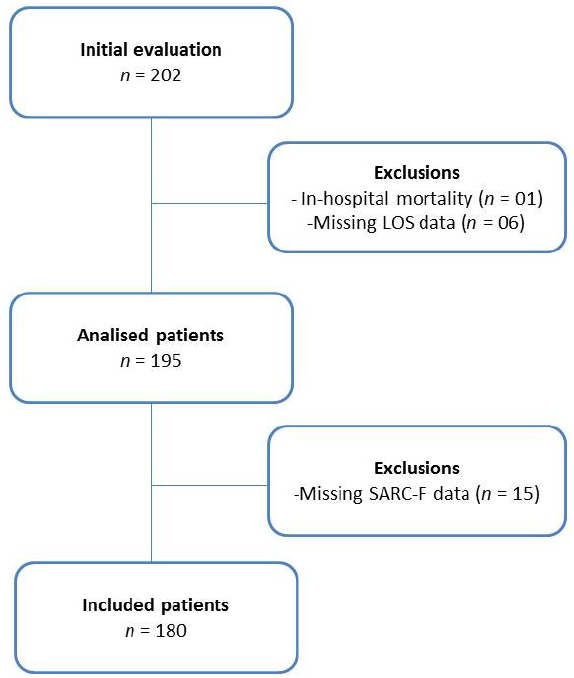
Figure 2. Flowchart of the cohort study.